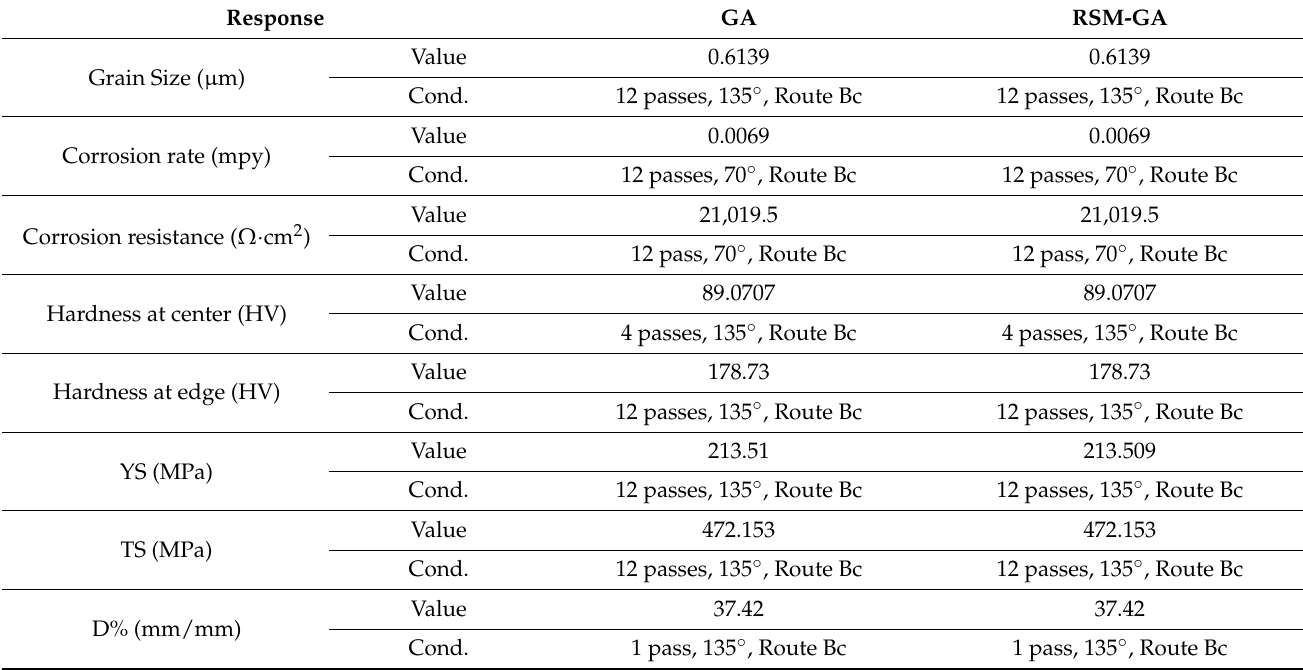
Table 5. Validated ECAP response based on previous